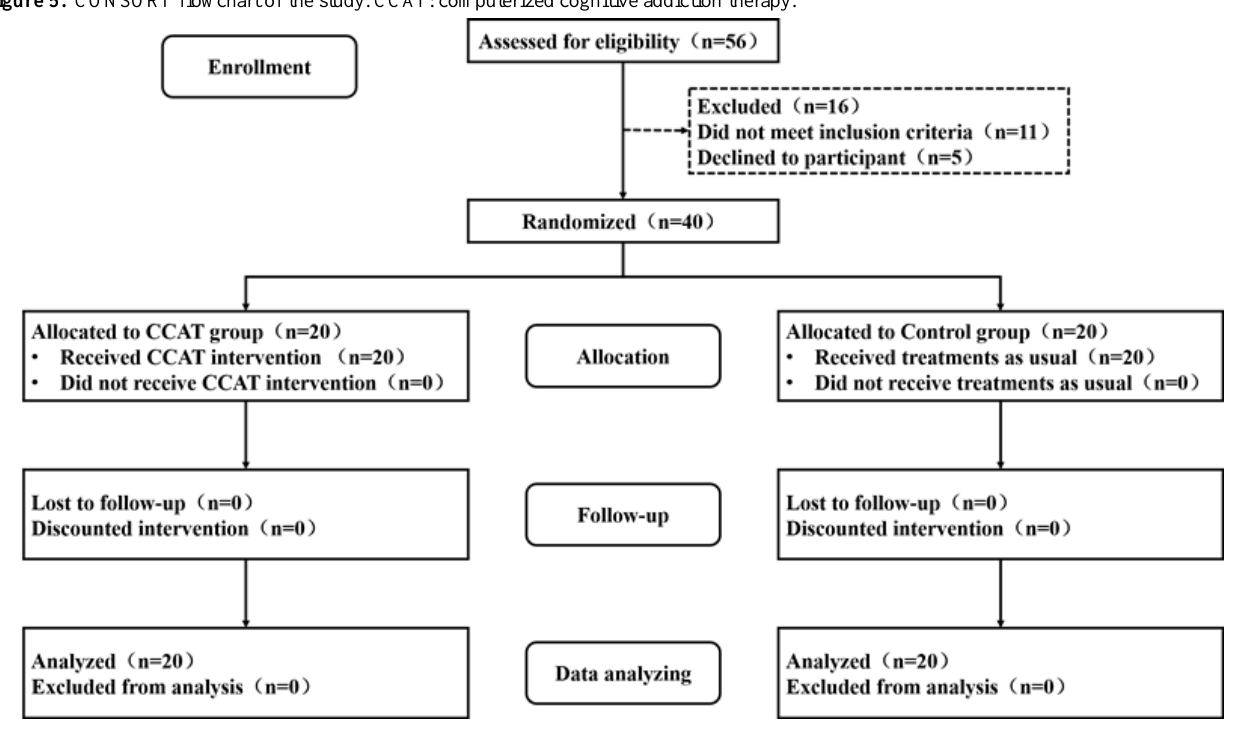
Figure 5. CONSORT flowchart of the study. CCAT: computerized cognitive addiction